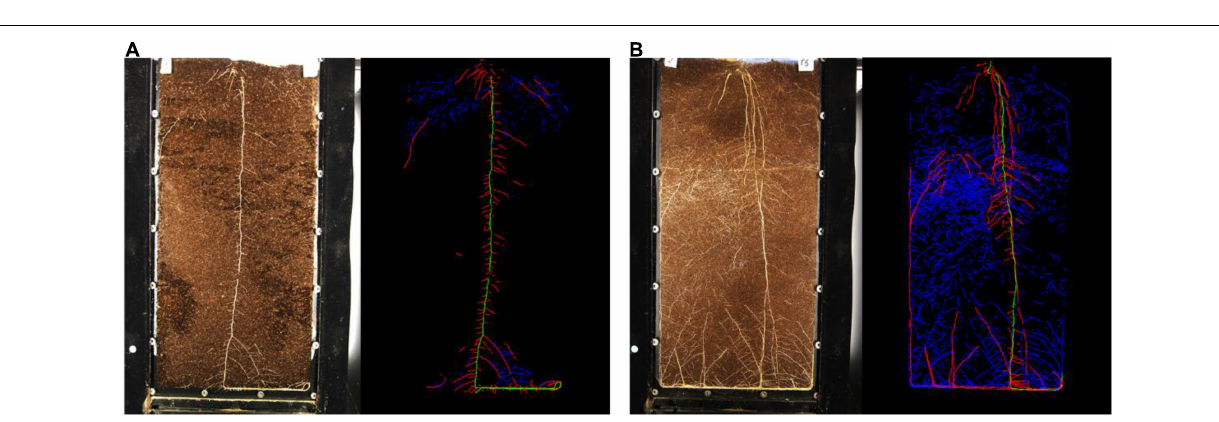
FIGURE 4 | Original and analyzed color coded rhizotron images of (A) control with no fertilizer and (B) St 50/PS treatment, 40 days after sowing. Primary roots and first and second order lateral roots are represented by the colors green, red, and blue,